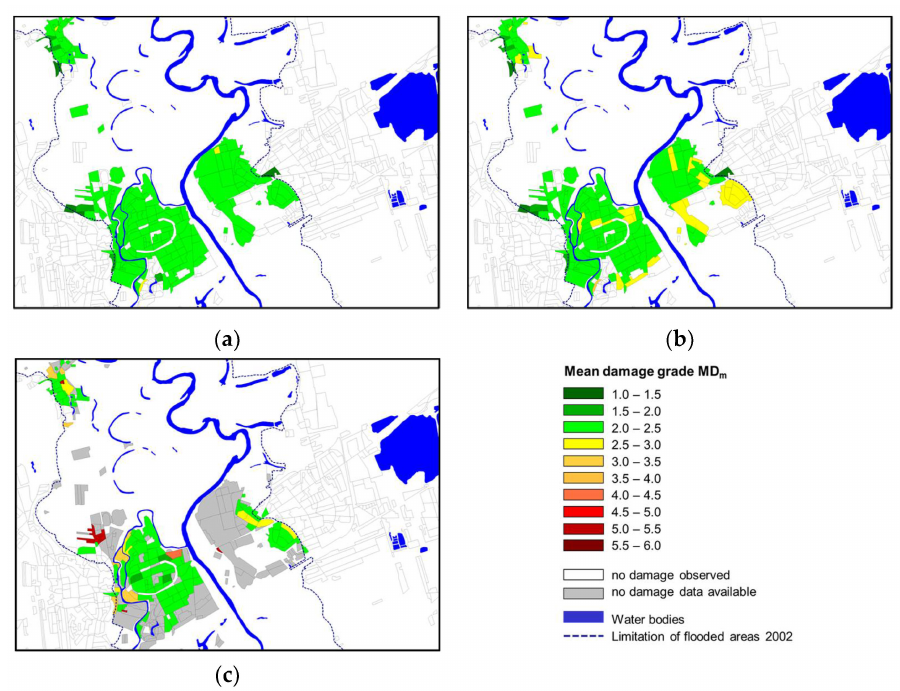
Figure 13. Comparison of the calculated mean damage grades ( MD m,calc ) in the land-use areas and the observed damages ( MD m,obs ) in the Eilenburg investigation area: ( a ) calculated mean damage grades ( MD m,calc ), Level I; ( b ) calculated mean damage grades ( MD m,calc ), Level II; ( c ) observed mean damage grades ( MD m,obs ).